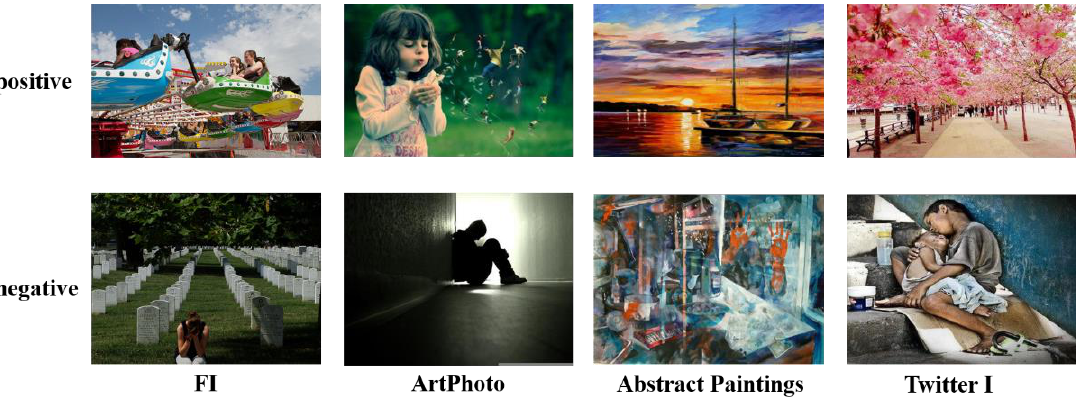
Figure 5. Some examples from the datasets we used.